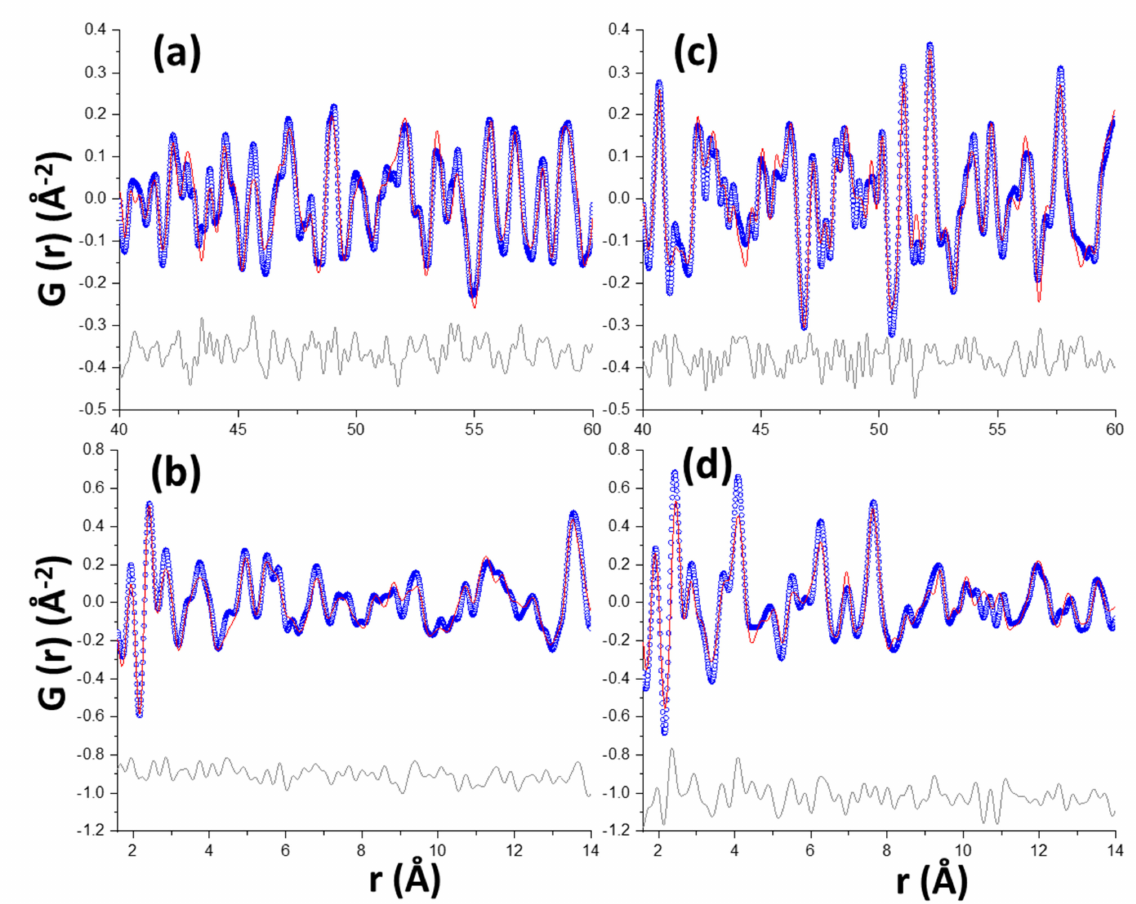
Figure 6. Experimental (blue circles) and fitted (red solid line) PDF patterns for Y-A_hyd: ( a , b ) panels and Y-A_carb: ( c , d ) panels. Difference curves are shown as grey lines at the bottom of each